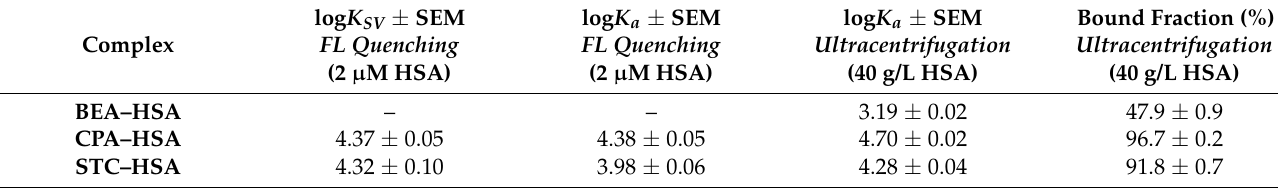
Table 1. Decimal logarithmic values of Stern–Volmer quenching constants ( K SV ; unit: L/mol)